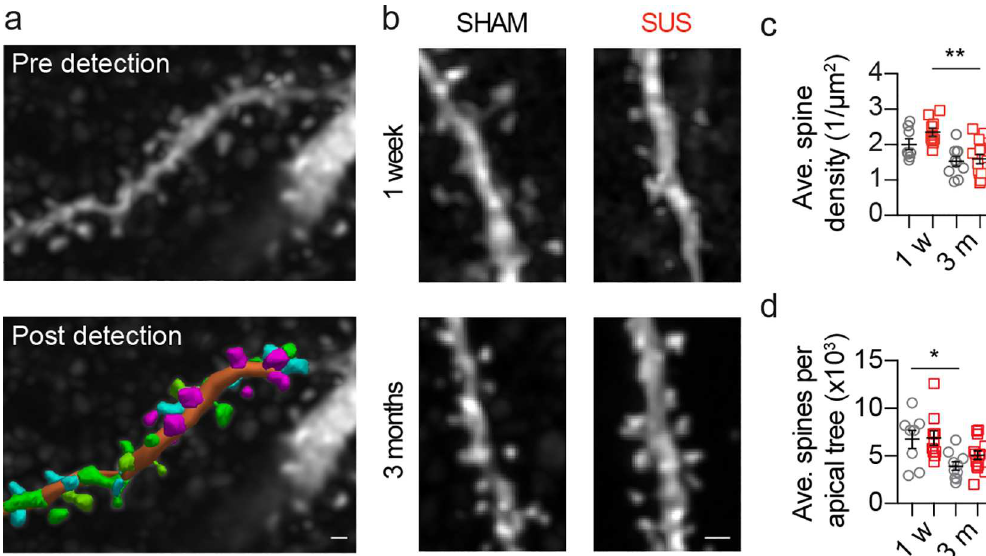
Fig 5. The dendritic density of CA1 neurons is not altered following multiple SUS treatments. (a) A representative fluorescent image of an apical dendritic branch and spines (top) demonstrating the 3D dendritic spine identification(bottom). (b) Representative confocal z-projections of spines from SUS and sham neurons. Graphs depict (c) the averageapical dendritic spine densities (SUS versus sham 1 w, p = 0.10, SUS 2.4 ± 0.11 1/ μ m 2 , sham 2.0 ± 0.15 μ m 2 ; SUS versus sham 3 m, p = 0.84, SUS 1.6 ± 0.13 μ m 2 , sham 1.5 ± 0.13 μ m 2 ; 1 w versus 3 m sham, p = 0.10, 1 w 2.0 ± 0.15 μ m 2 , 3 m 1.5 ± 0.13 μ m 2 ; 1 w versus 3 m SUS, p = 0.0012, 1 w 2.4 ± 0.11 1/ μ m 2 , 3 m 1.6 ± 0.13 μ m 2 ) and (d) the average number of apical dendritic spines (SUS versus sham 1 w, p = 0.82, SUS 6871 ± 765.3 spines, sham 6749 ± 948.8 spines; SUS versus sham 3 m, p = 0.11, SUS 5077 ± 450.1 spines, sham 3937 ± 439.8 spines; 1 w versus 3 m sham, p = 0.0343, 1 w 6749 ± 948.8 spines, 3 m 3937 ± 439.8 spines; 1 w versus 3 m SUS, p = 0.07, 1 w 6871 ± 765.3 spines, 3 m 5077 ± 450.1 spines). Data are presented as mean ± SEM and as individualdata points. * p < 0.05 and *** p < 0.001. Sample size: one week time-point—SUS n = 8 neurons and sham n = 10 neurons. 3 month time-point—SUS n = 14 neuronsand sham n = 10 neurons. Scale bar: 0.5 μ